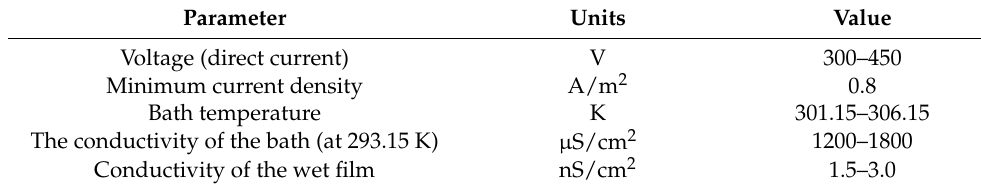
Table 2. Operating conditions of typical CED tanks, adapted from [16].